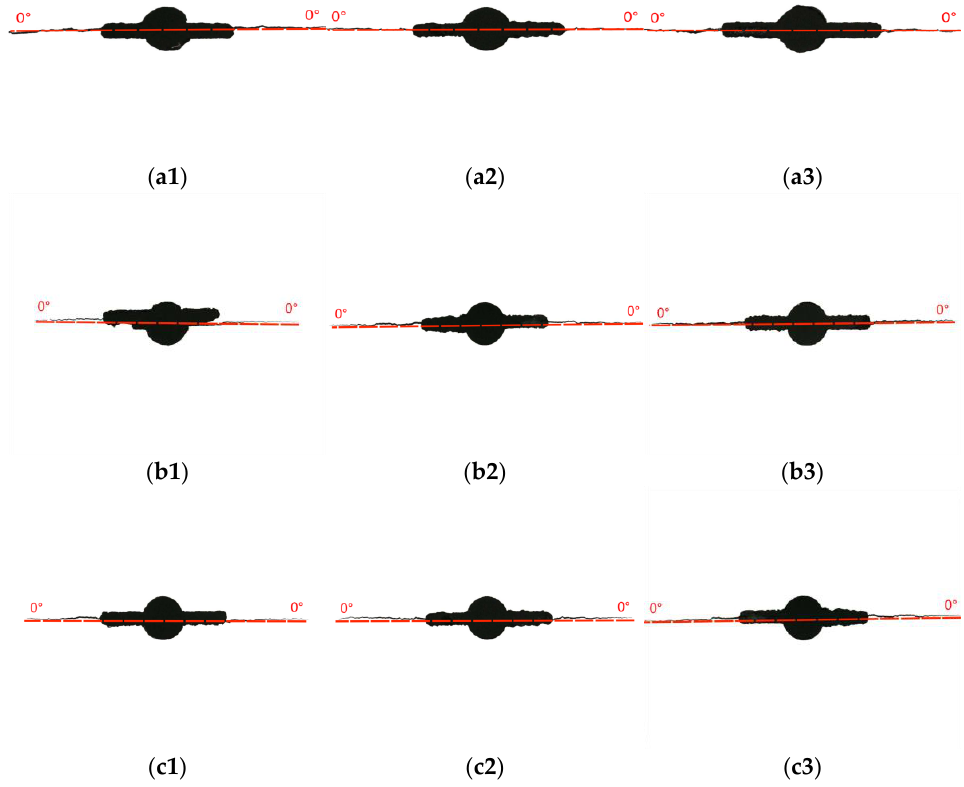
Figure 2. Propagation path under crack inclination angle 90°. ( a1 ) β = 90°, λ = 0, R = 0. ( a2 ) β = 90°, λ = 0, R = 0.1. ( a3 ) β = 90°, λ = 0, R = 0.3. ( b1 ) β = 90°, λ = 0.5, R = 0. ( b2 ) β = 90°, λ = 0.5, R = 0.1. ( b3 ) β = 90°, λ = 0.5, R = 0.3. ( c1 ) β = 90°, λ = 1, R = 0. ( c2 ) β = 90°, λ = 1, R = 0.1. ( c3 ) β = 90°, λ = 1, R = 0.3.